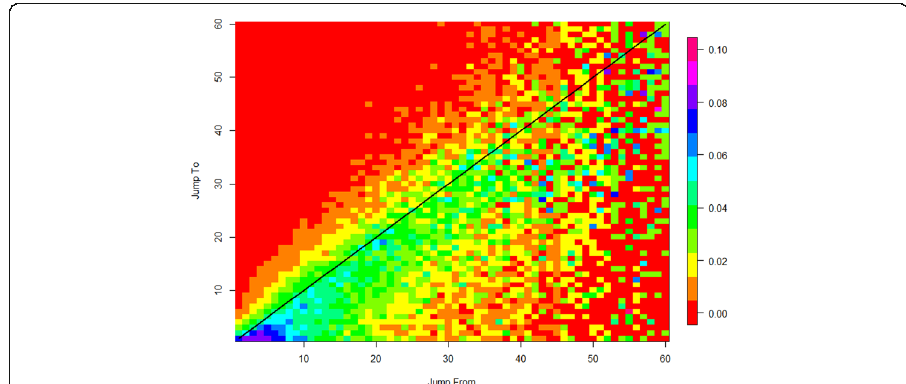
Fig. 3 A heat map of the degree transitions over time. The X-axis marks the degree in the current period and the Y-axis marks the degree in the following 60 days. The probability of a transition from degree X to degree Y is color coded